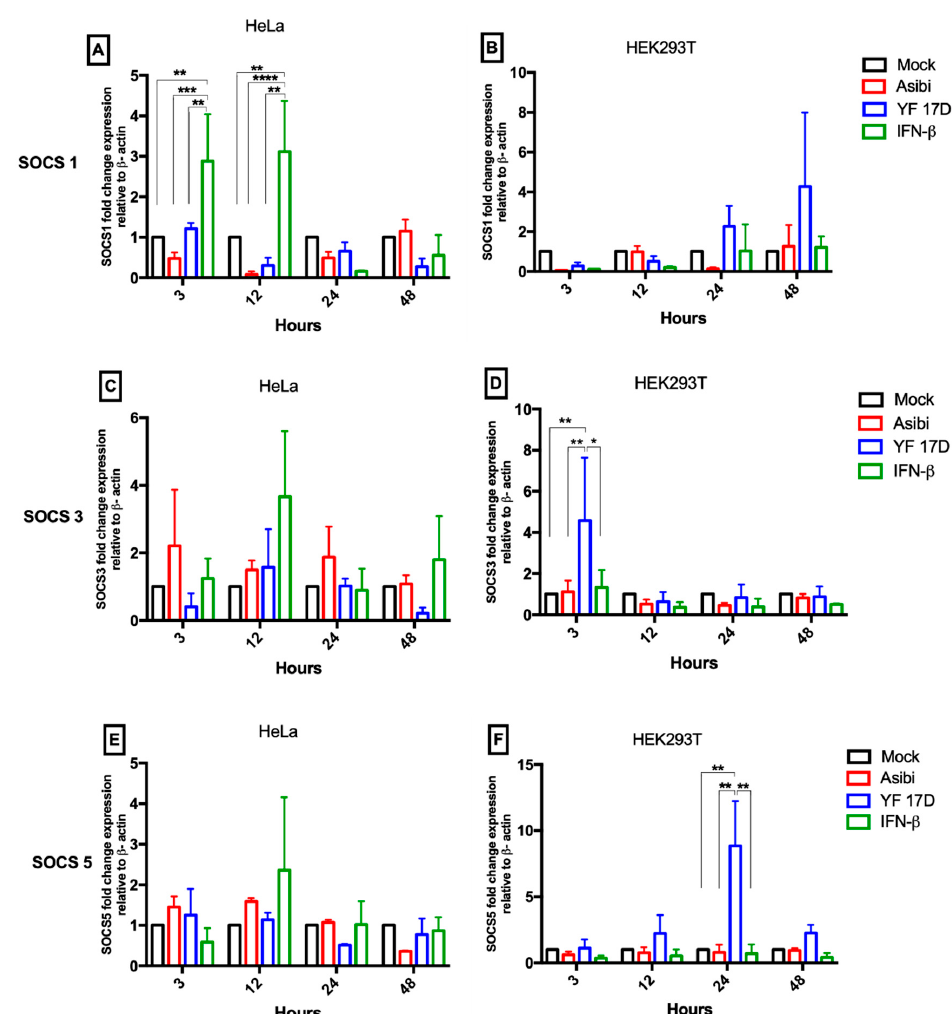
Figure 3. Expression dynamics of SOCS genes. Hela and HEK293T cells were infected with either Asibi or YF-17D at MOI = 1. Positive control cells were stimulated with IFN- β while unstimulated uninfected cells served as negative controls. At the indicated time points, cells were processed, and RNA extracted. Expression levels of SOCS1 ( A , B ), SOCS3 ( C , D ) and SOCS5 ( E , F ) were determined by RT-qPCR and expressed as fold change difference with β -actin as endogenous control. Data represent two independent experiments performed in triplicates and are presented as mean ± SEM. * = p ≤ 0.05, ** = p ≤ 0.01, *** = p ≤ 0.001, **** = p ≤